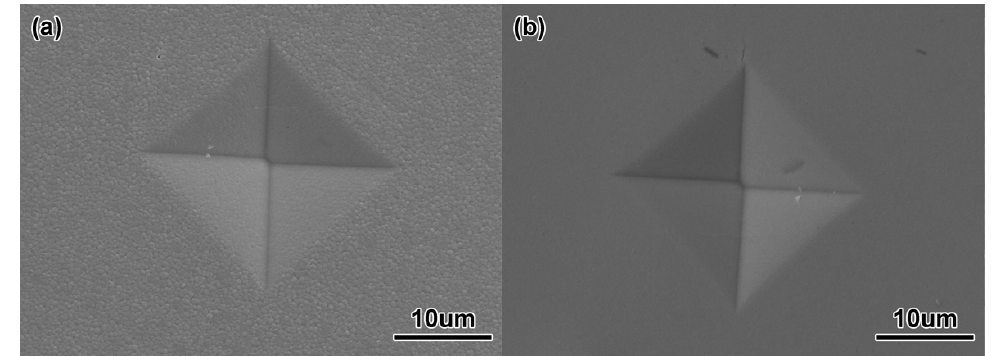
Figure 13. Indentation images of ZrO 2 samples ( a ) 200 nm, ( b ) 100 nm.